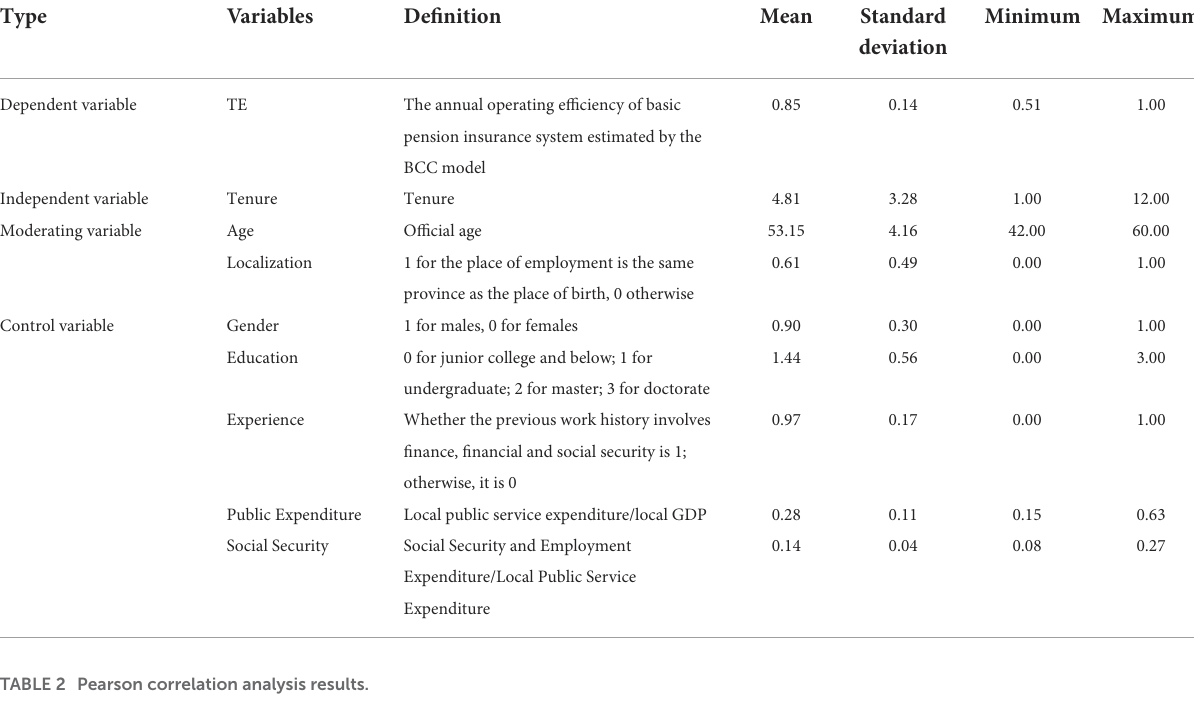
TABLE 1 Descriptive analysis of inputs, outputs and environmental variables.